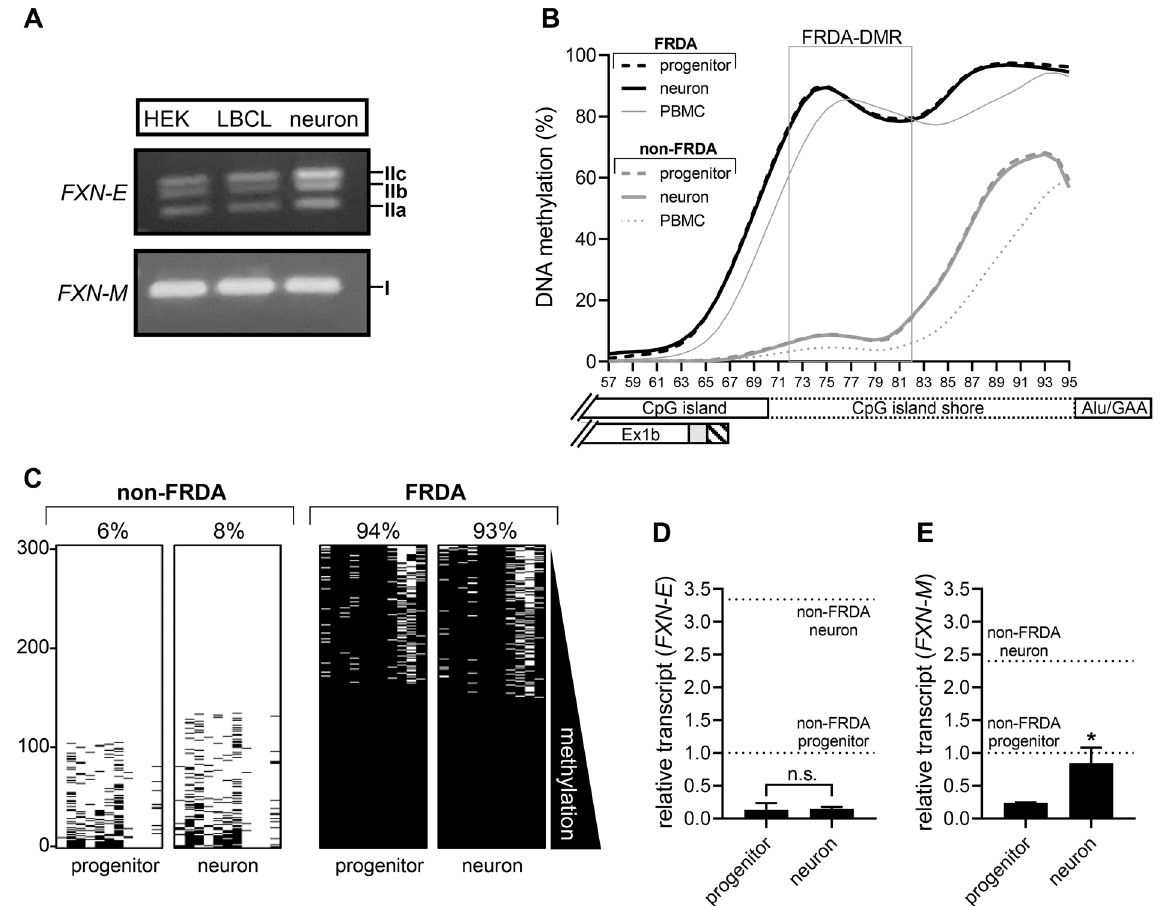
Figure 5. FRDA-DMR hypermethylation and deficiency of FXN-E transcript in iPS-derived proprioceptive neurons in FRDA. ( A ) Proprioceptive neurons derived from non-FRDA control iPS lines express FXN-M (isoform I) and FXN-E (isoforms IIa, IIb, and IIc). Note: Uncropped gel images are included in Fig. S14. ( B ) DNA methylation is plotted as a percentage of 1000 sequencing reads, at each of 39 CpG dinucleotides (numbered 57–95) that map between the 3 ′ end of the CpG island and the Alu repeat element that contains the expanded GAA repeat. Data are displayed as LOWESS trendlines for FRDA (neurons [n = 3]; neuronal progenitors [n = 3]; PBMCs [n = 32]) and non FRDA controls (neurons [n = 1]; neuronal progenitors [n = 1]; PBMCs [n = 14]). The FRDA-DMR is outlined with a gray box, and the relative locations of the CpG island, CpG island shore, Alu/GAA, and Ex1b are indicated. ( C ) FRDA-DMR methylation assayed as a single amplicon to test each of the n = 11 CpG dinucleotides in cis displayed as n = 300 sequencing reads stacked vertically for both neuronal progenitors and proprioceptive neurons from FRDA and non-FRDA controls (black dash = methylated CpG; reads are sorted with highest methylation at the bottom). ( D ) FXN-E and ( E ) FXN-M transcript levels in non-FRDA neuronal progenitors (n = 1) and proprioceptive neurons (n = 1) are shown as dotted horizontal lines. Transcript levels in FRDA neuronal progenitors (n = 3) and proprioceptive neurons (n = 3) are shown as black bars (mean ± SD); for FXN-E : p = 0.7953, t = 0.2773, df = 4, and for FXN-M : p = 0.0107, t = 4.511, df = mouse 35 . RT-PCR of tissues from the Y47R mouse showed the same three predominant spliceforms of FXN-E formed by alternate splicing of exon 1b to exon 2 (isoforms IIa, IIb, IIc; Fig. 6A). In the Y47R mouse, FXN-E was found to be expressed in the cerebellum and heart but was seen at very low levels in skeletal muscle (Fig. 6B), which contrasted with FXN-M , which was detectable in all three tissues, and expressed at a relatively high level in the heart (Fig. 6C). Both FXN-E and FXN-M transcripts were deficient in all tissues in the YG8sR mouse (GAA- 480), although the deficiency of FXN-M transcript was less pronounced in the heart (Fig. 6B,C). The YG8sR mouse clearly showed increased DNA methylation in the FRDA-DMR in all tissues, but it was notable for being rather low (20–30% methylation, with somewhat lower levels in the heart) compared with what is seen in human cell types with expanded GAA repeats (Fig. 6D). There were no obvious differences in the level of FRDA-DMR methylation in male versus female mice, and in young (1 month) versus older (12 month) mice (Fig. S11A-C). Somatic instability of the expanded GAA repeat was ruled out as an explanation for the variability in levels of transcript or DNA methylation, as the expanded repeat remained mostly unchanged in all three tissues, across different mice (Fig. S12; note: slight instability was noted in the cerebellum, consistent with previous studies 36–38 ).